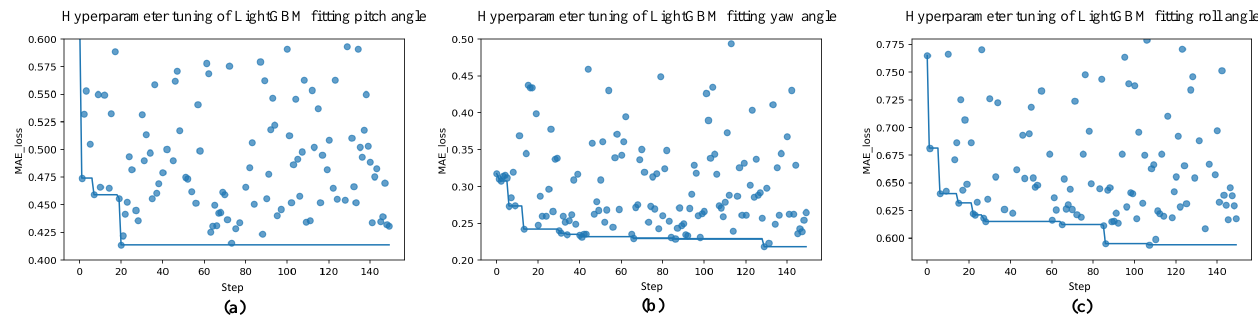
Figure 12. Variation of L1 loss of the validation set during the optimization iterations of LightGBM. ( a – c ) indicate the tuning process when LightGBM fits the pitch, yaw, and roll angles, respectively. The blue circles in the figure indicate the L1 loss values of the model on the validation set for each iteration. The optimal hyperparameters for the LightGBM hand pose regression model after Bayesian optimization and tuning are summarized in Table 1. The parameter num_iterations , which represents the number of model iterations, was determined dynamically using an early stop mechanism during model training. The number of iterations was set to best_iteration when the loss value on the validation set no longer decreased after I iterations, and in this experiment, the I was taken to be 20. The LightGBM model for hand pose esti- mation (ConvLGBM 2) was trained using Bayesian tuning of the optimal hyperparameters. Figure 13 shows the loss curve of the LightGBM hand attitude estimation model during training. Table 2 gives the MSE, MAE, and R 2 metrics and the training time of the model on the training and test sets after the model was